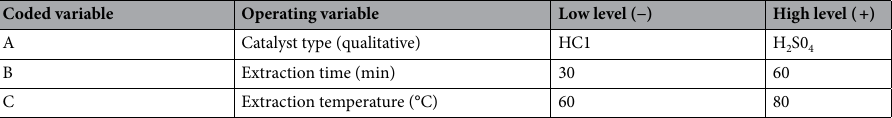
Table 1. Operating variables values used in the 2 3 -factorial design studies for each biomass in the pectin extraction